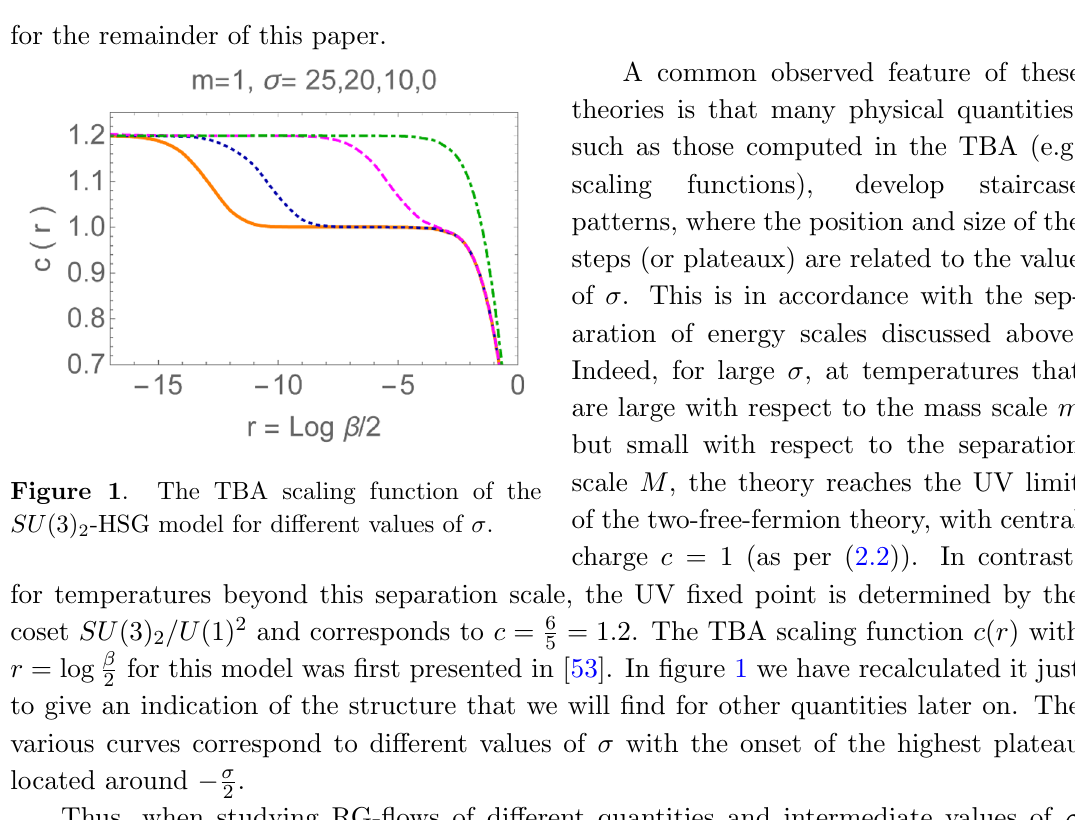
theories is that many physical quantities, such as those computed in the TBA (e.g. scaling functions), develop staircase patterns, where the position and size of the steps (or plateaux) are related to the value of (cid:27) . This is in accordance with the sep- aration of energy scales discussed above. Indeed, for large (cid:27) , at temperatures that are large with respect to the mass scale m but small with respect to the separation scale M , the theory reaches the UV limit of the two-free-fermion theory, with central charge c = 1 (as per (2.2)). In